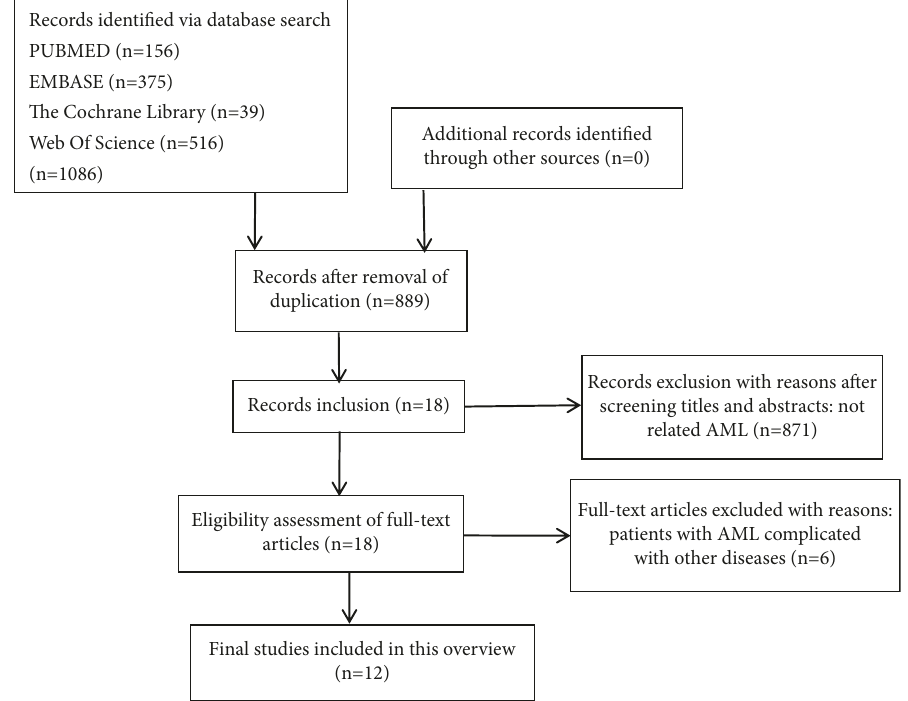
Figure 1: Flow diagram of study